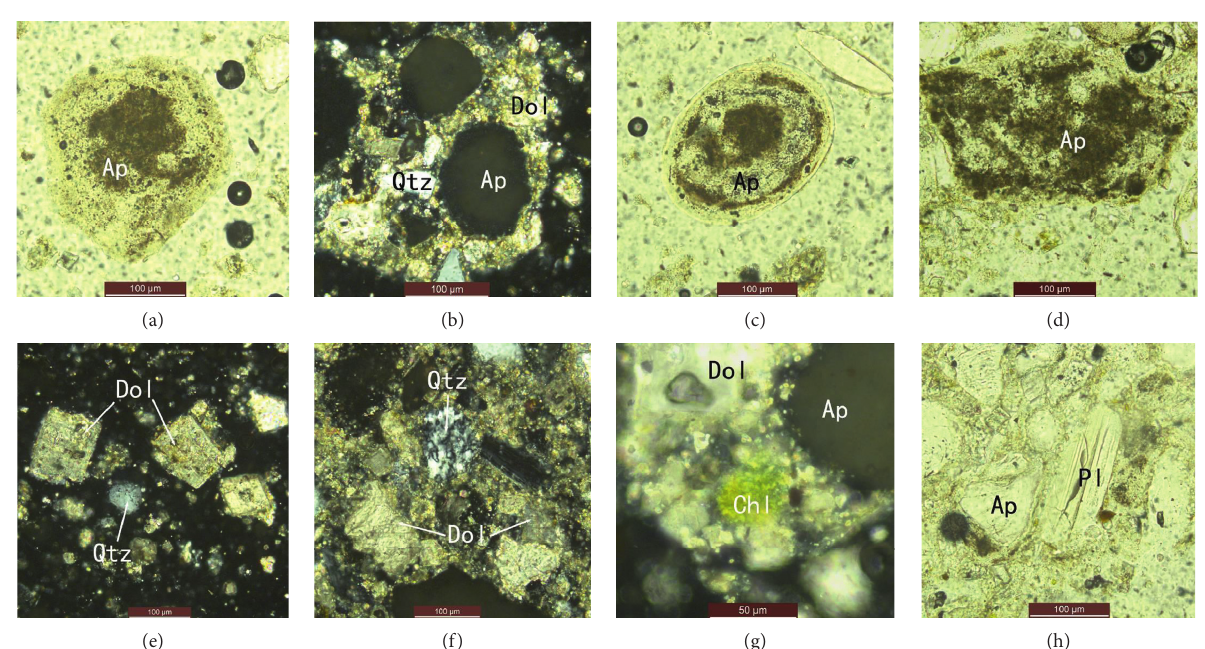
Figure 1: Phosphate tailings’ mineral structure (TSPL represents transmitted single polarized light, and TCPL represents transmitted crossed polarized light). (a) Colloidal aphanitic collophane (Ap) detritus (TSPL). (b) Fine-grained sand clastic collophane (Ap), quartz (Qtz) (TSLP). (c) Oolitic collophane detritus (TSPL). (d) Dusty substance coated with collophane (Ap) (TSPL). (e) Fine-grained (0.1–0.3 mm) dolomite (Dol) (TSPL). (f) Microcrystalline quartz (Qtz) aggregates (TCPL). (g) Microscopic scaly chlorite (Chl) (TCPL). (h) Allo- triomorphic granular plagioclase (PI)